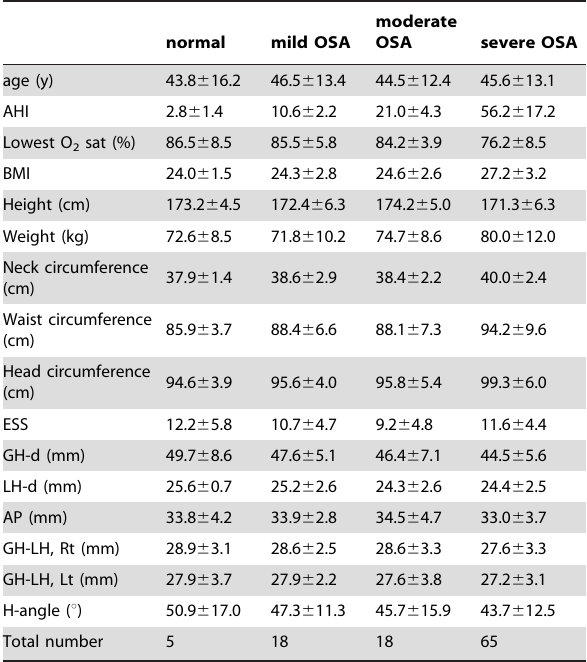
Table 1. Patients